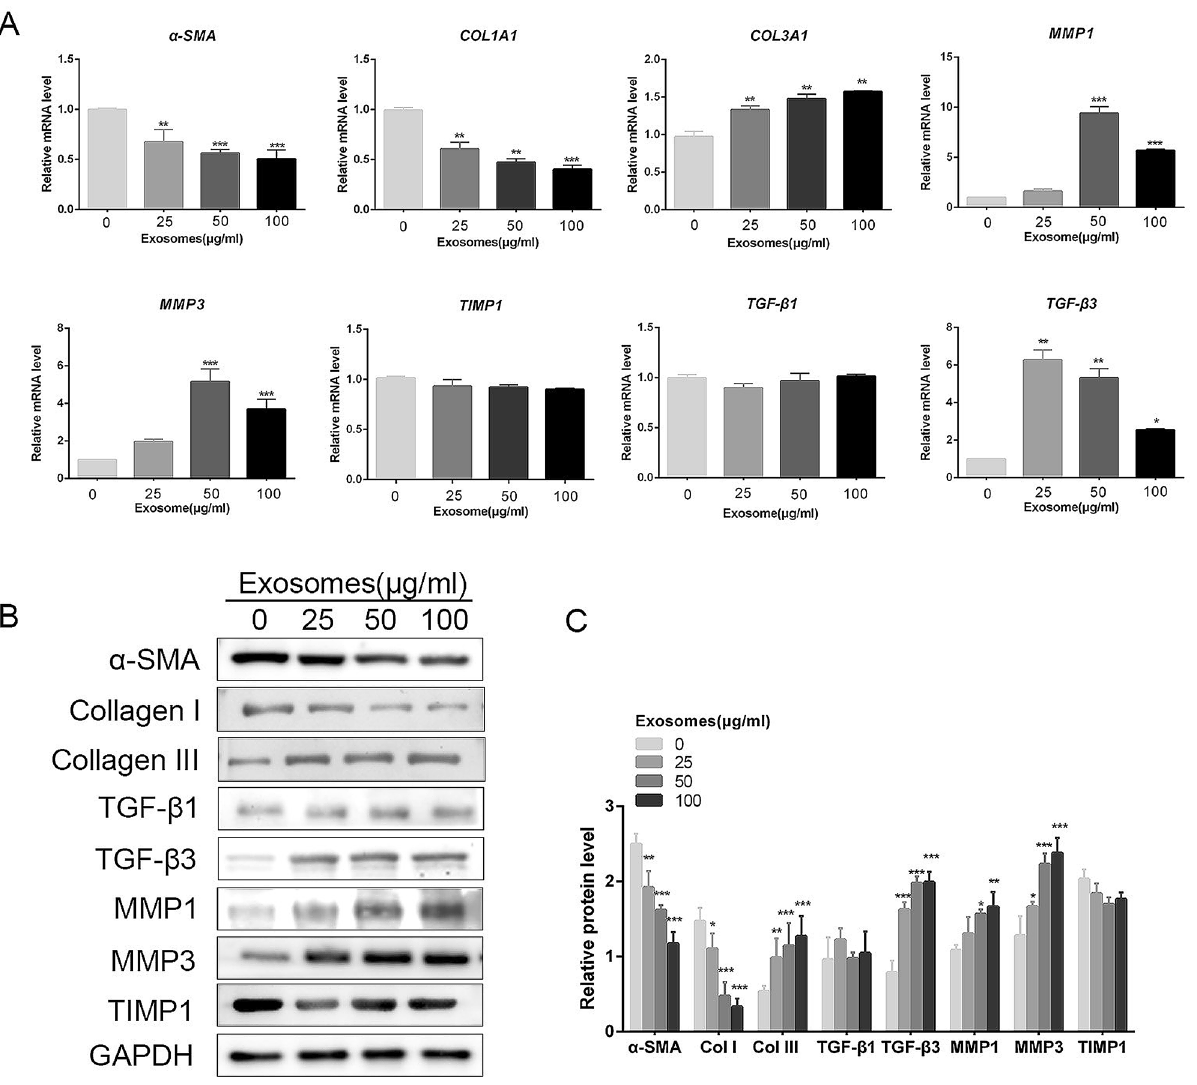
Figure 2. The original incorrect version of Figure